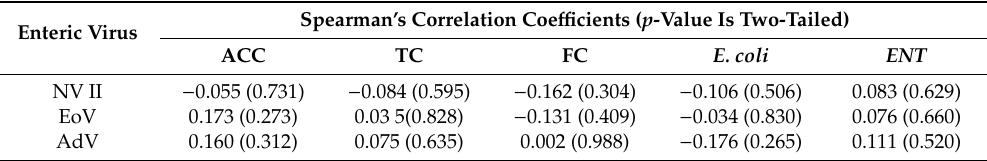
Table 11. Correlation of enteric viruses between bacteriological index in Poyang